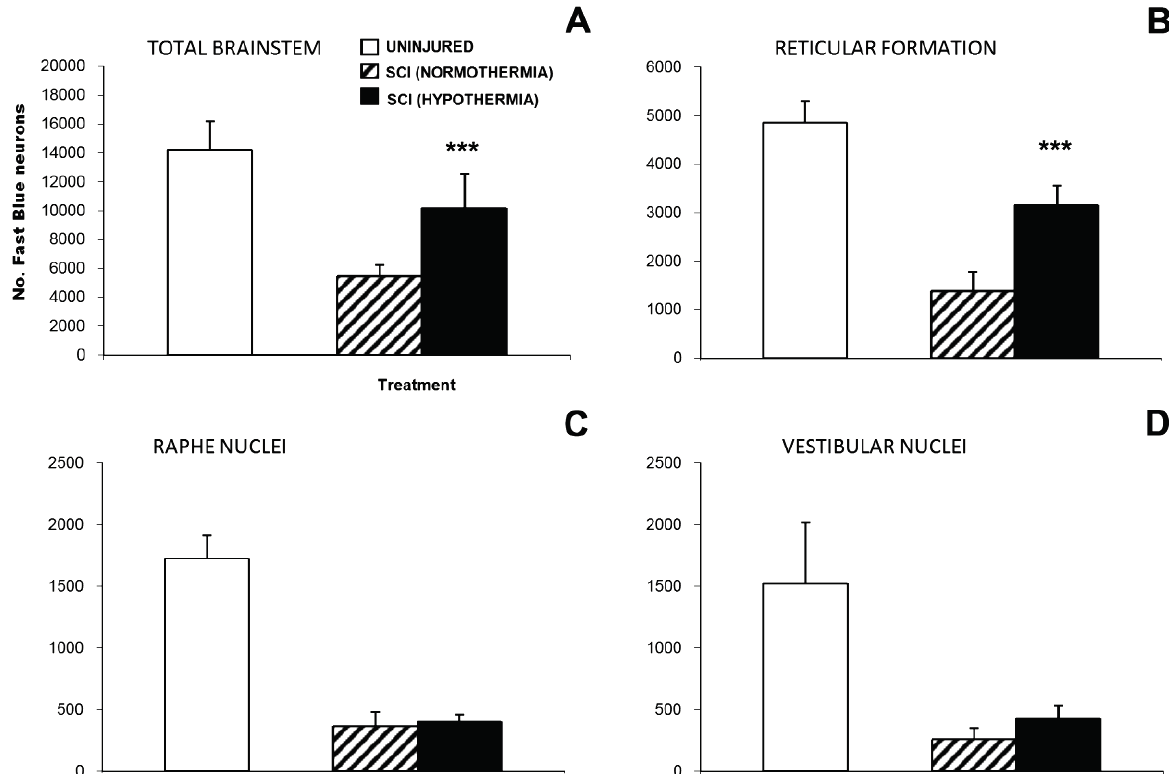
Figure 3. Retrograde tracing analysis reveals that acute hypothermia resulted in greater sparing of brainstem axons projecting caudal to the injury site at 10 weeks post cervical spinal cord injury. ( A ) Retrograde labeling of neuronal somata with fast blue (FB), provided caudal to the lesion, shows that there was a greater sparing of brainstem projections (indicated by an increase in numbers of labeled neuronal perikarya) when acute hypothermia was applied. Investigation of specific brainstem neuronal populations revealed a significant increase in retrogradely labeled neurons in the reticular formation ( B ) but not the raphe ( C ) or vestibular nuclei ( D ) after hypothermia treatment. Recordings from uninjured controls are provided for comparison, and the data are expressed as the average ± standard error of the mean. *** p < 0.001 compared with normothermic controls. Reprinted with permission from [42], copyright Wiley-Liss, Inc.,